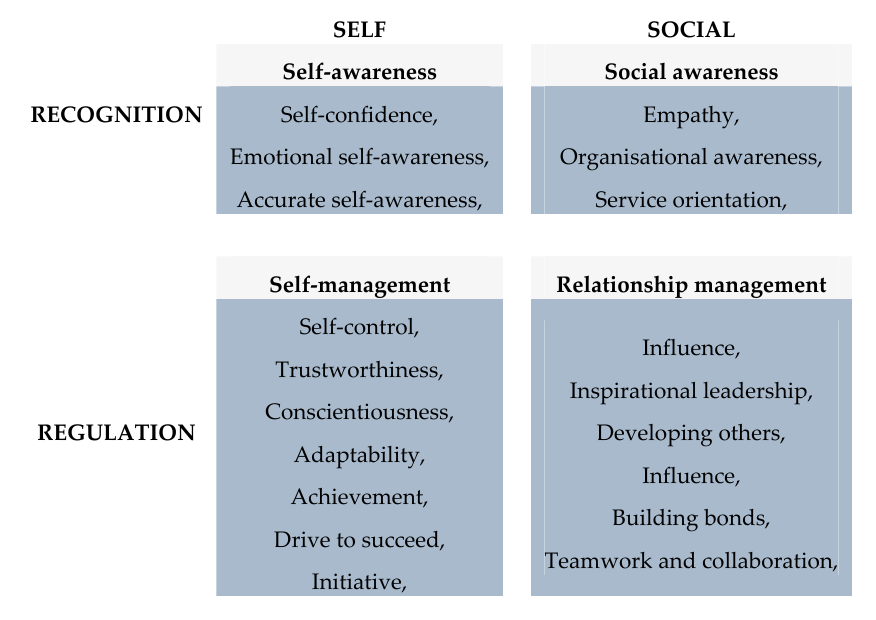
Figure 2. The four broad domains of emotional intelligence (Goleman 2012).